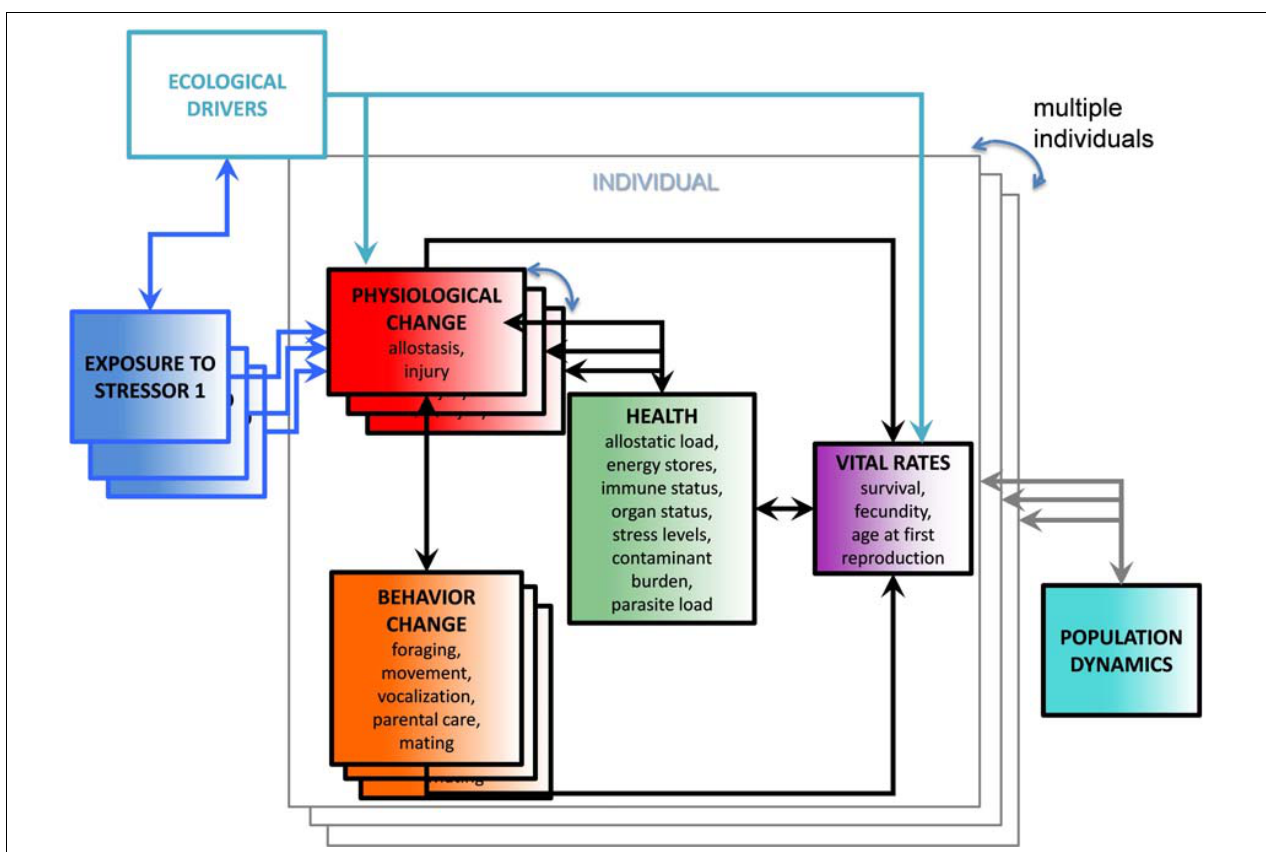
FIGURE 2 | The Population Consequences of Multiple Stressors (PCoMS) framework [reproduced with permission from National Academies of Sciences, Engineering and Medicine (2017)]. Multiple slices of the PCoMS represent multiple